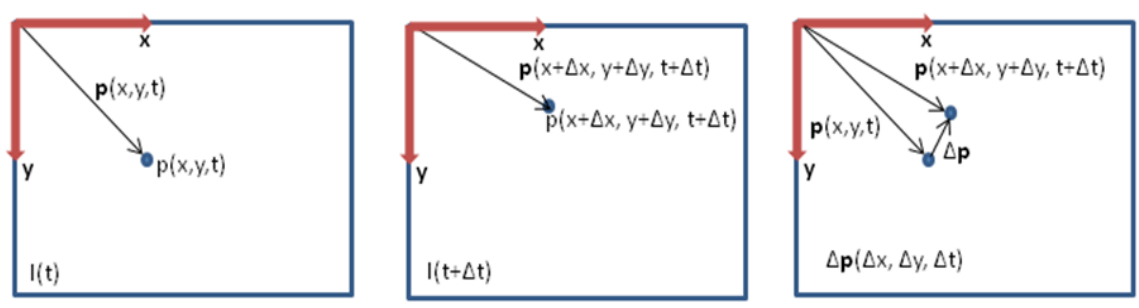
Figure 6. Optical